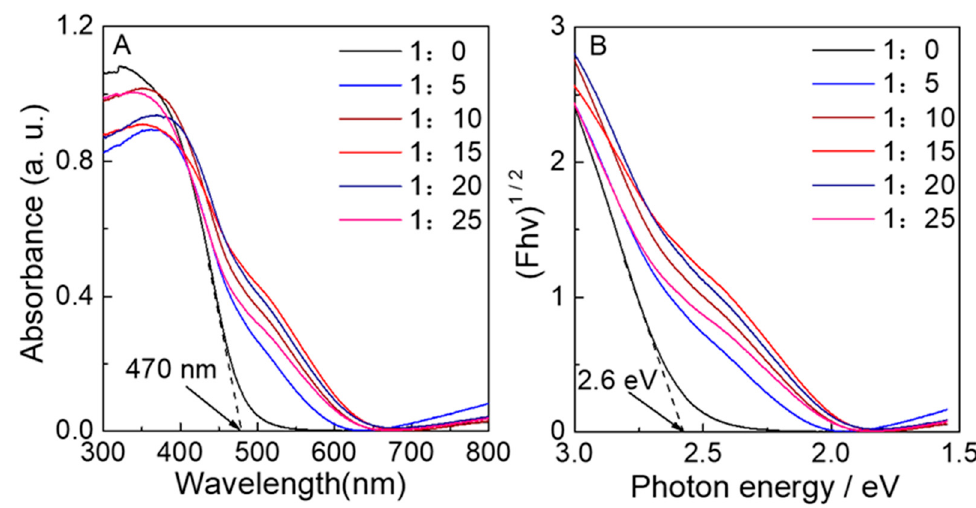
Figure 5. ( A ) UV-Visible DRS and ( B ) Tauc plots based on UV-Visible DRS of (black) WO 3 − 0, (blue) WO 3 − 5, (wine) WO 3 − 10, (red) WO 3 − 15, (navy) WO 3 − 20, and (pink) WO 3 − 25.